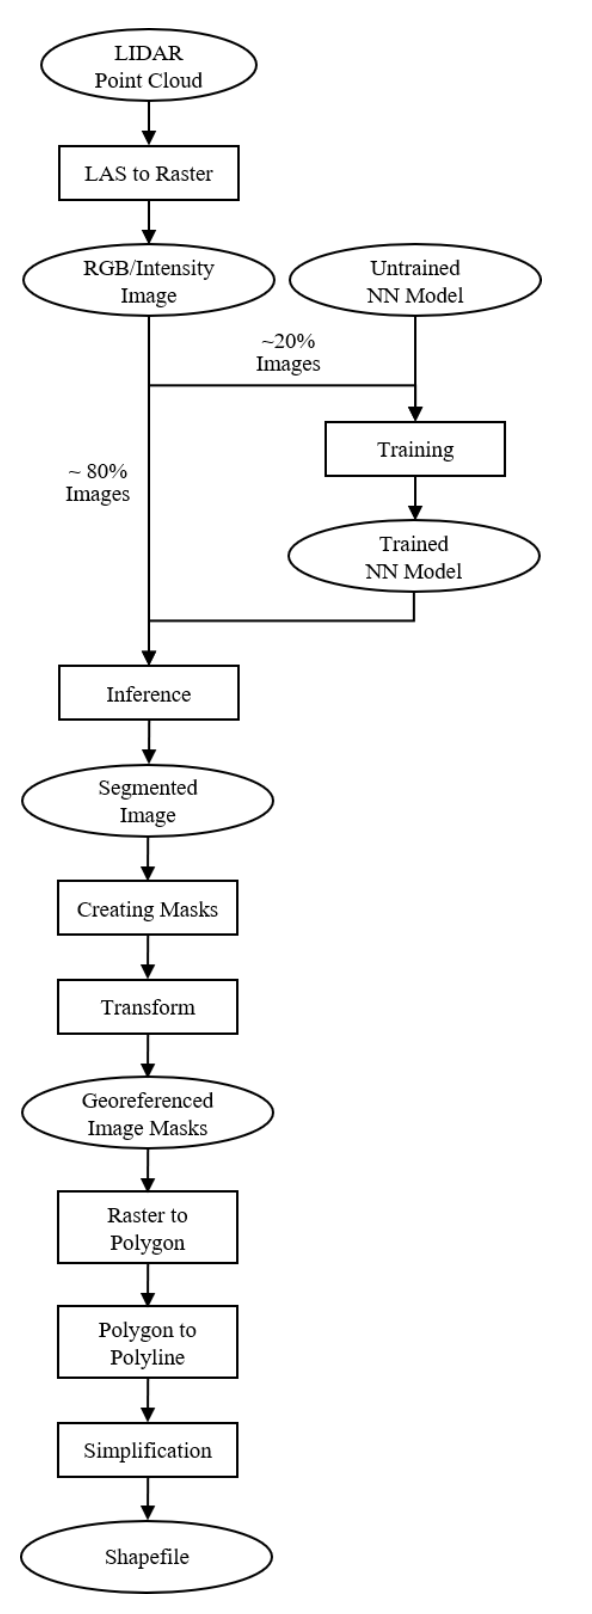
Figure 3. General workflow of the entire methodology .